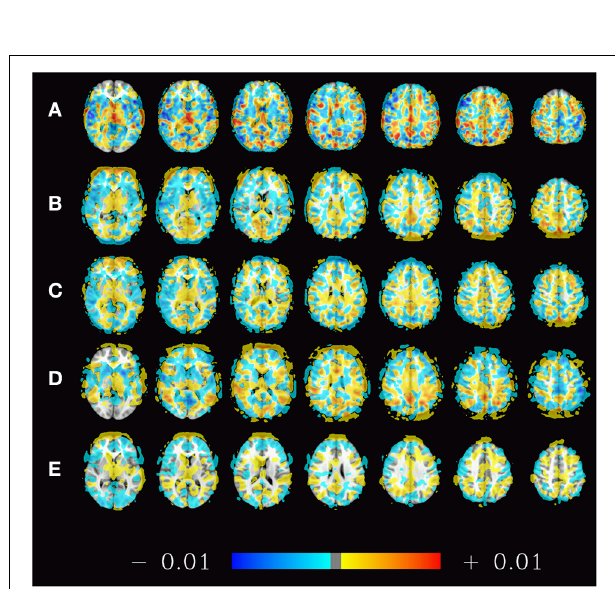
FIGURE 8 | Spatial distribution (mean weights) of voxels contributing to the 1000 classifiers trained on the training samples of the pooled dataset (A), the datasets of Beijing (B), Cambridge (C), ICBM (D), and Oulu (E) with sample sizes of 200, 70, 70, 40, and 30 subjects, respectively. The maps presented thus correspond to the rightmost bars in the subfigures of Figure 2 as well as the left subfigure of Figure 6 . Positive weights indicate higher ReHo values in males, negative weights indicate higher ReHo values in females.